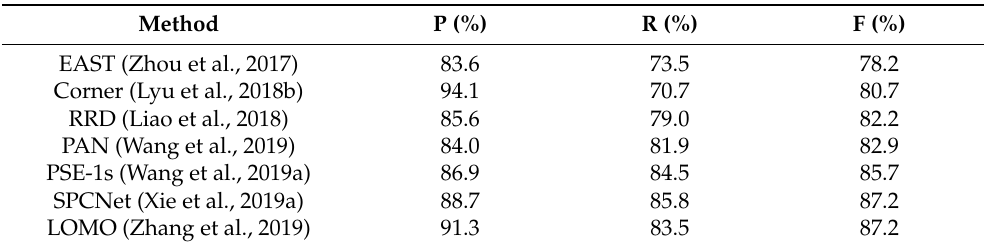
Table 7. Test results of ICDAR 2015 dataset (the values in brackets indicate the height of the input